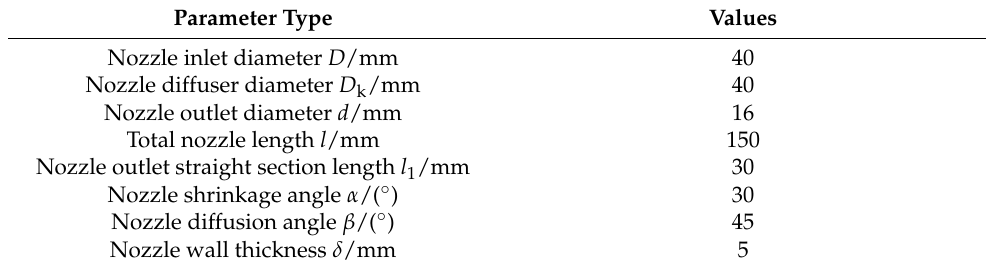
Figure 5. Nozzle structure diagram. ( a ) Cylindrical nozzle, ( b ) Conical nozzles, ( c ) Conical-cylindrical nozzles, ( d ) Diffusion nozzles. Note: l is the total length of nozzle, mm; l 1 is the nozzle outlet straight section length, mm; δ is Nozzle wall thickness, mm; D k is Diffusion nozzle diffusion outlet diameter, mm; β is Nozzle diffusion angle, ( ◦ ). Table 3. Nozzle geometry model parameters.